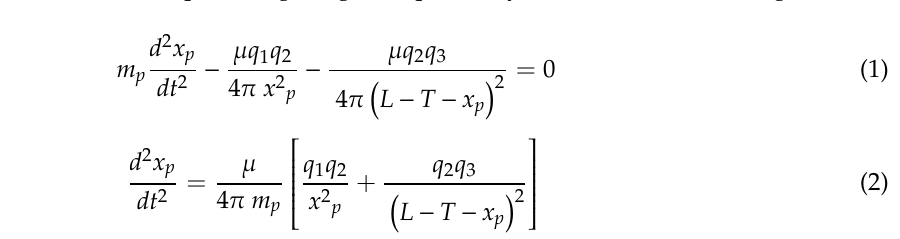
Figure 15. Geometric layout of the EMP device with a crankpin.